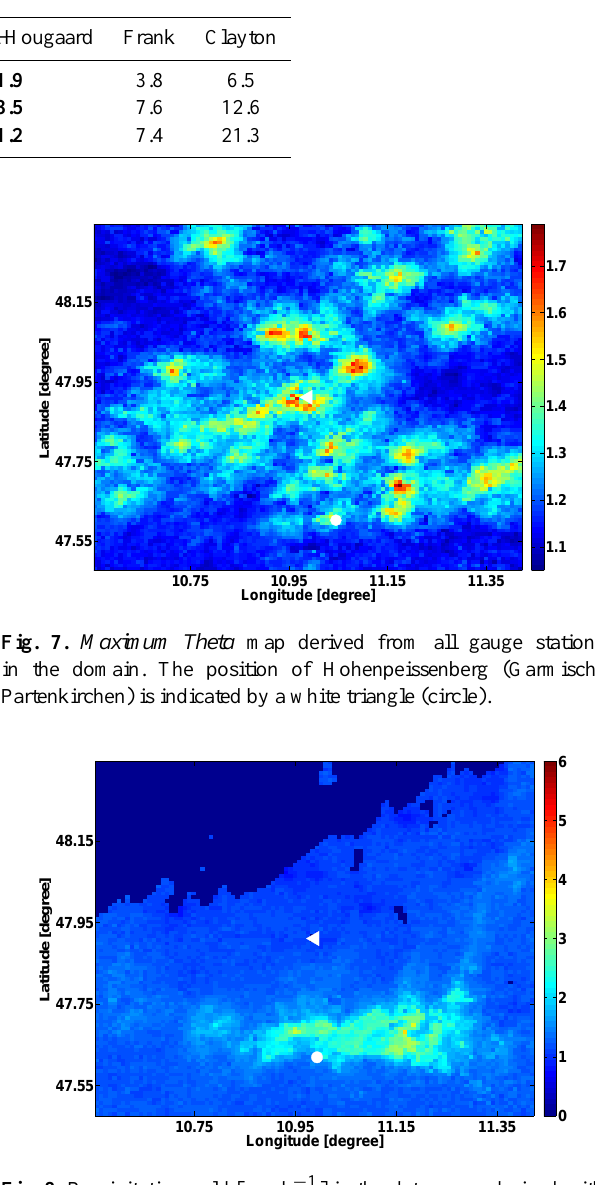
Fig. 8. Precipitation field [mmh − 1 ] in the data space derived with Fig. 8: Precipitation field [mm/h] in the data space derived the Multiple Theta method for 14 July 2008 (13:00). The position with the Multiple Theta method for 14/07/2008 (13:00). The of Hohenpeissenberg (Garmisch-Partenkirchen) is indicated by a position of Hohenpeissenberg (Garmisch-Partenkirchen) is white triangle indicated by a white triangle (circle).